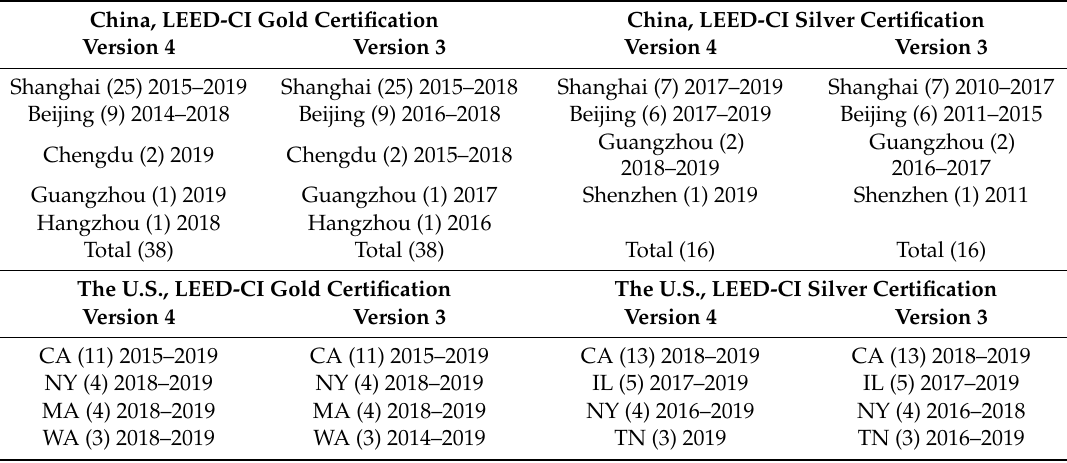
Table 1. Spatial–temporal characteristics of Leadership in Energy and Environmental Design Commercial Interiors (LEED-CI)-certified projects in China and the